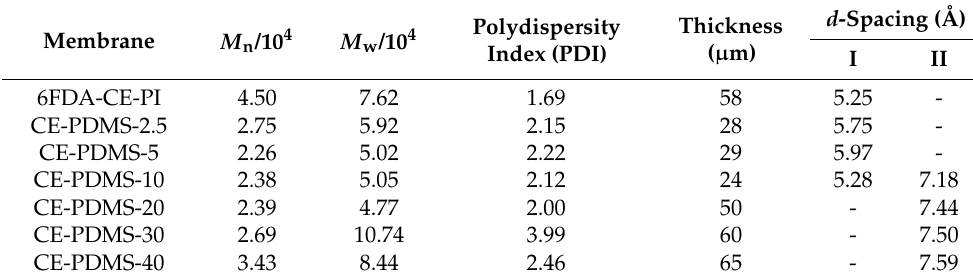
Table 1. Comparison of the monomer ratios and molecular weight distributions of the CE-PDMS-x